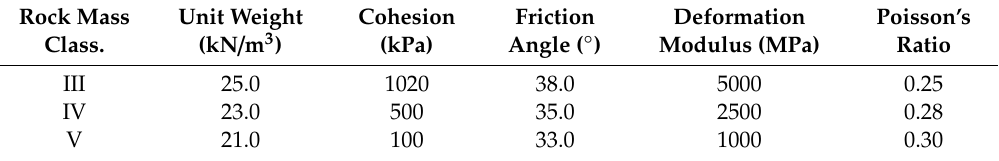
Table 1. Mechanical material properties of di ff erent rock mass